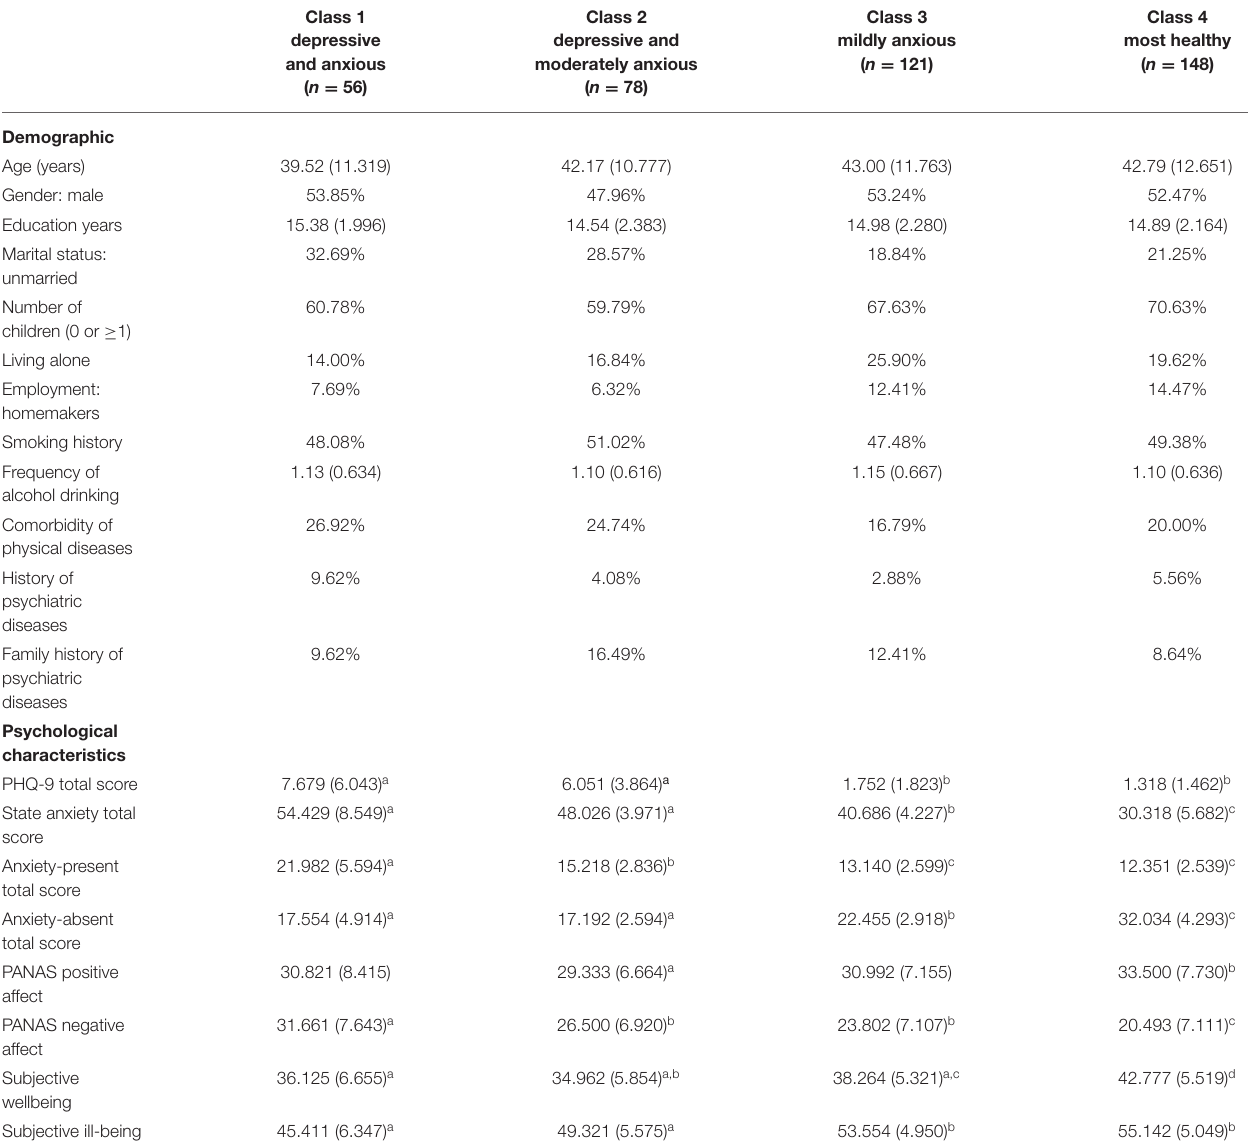
TABLE 2 | Demographic and psychological characteristics of the 4 latent